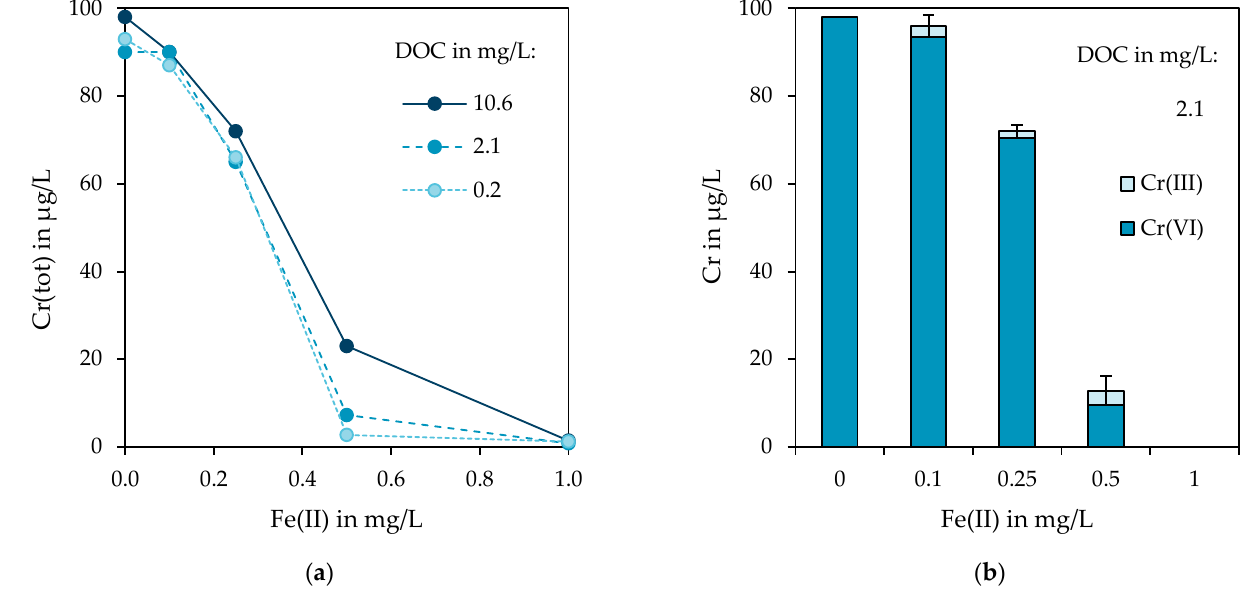
Figure 5. Residual concentrations of Cr(tot) ( a ), and Cr(VI) and Cr(III) ( b ), in batch tests with a fixed dose of pre-formed sludge and increasing dosages of fresh Fe(II) at different HA concentrations (0.2–10.6 mg/L DOC). Test conditions: 100 µg/L Cr(VI), 100 mg/L Fe(III), 0–1.0 mg/L Fe(II), pH 7.5, 0.2–10.6 mg/L DOC, t = 60 min, n = 1/2; error bars indicate minimum and maximum.